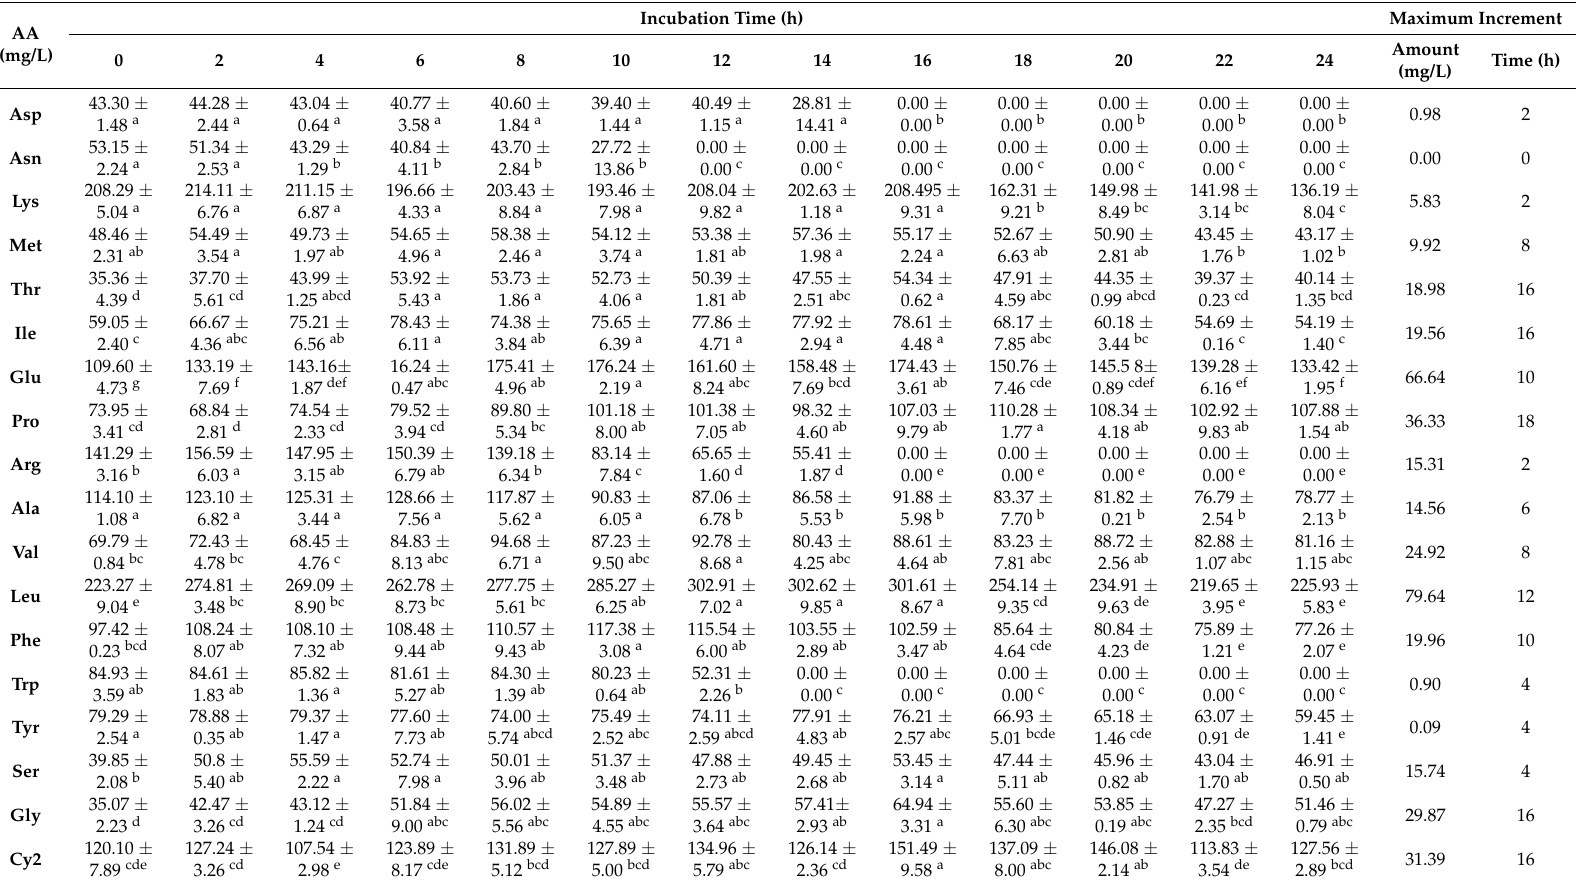
Table 5. The amino acid production profile of P. pentosaceus